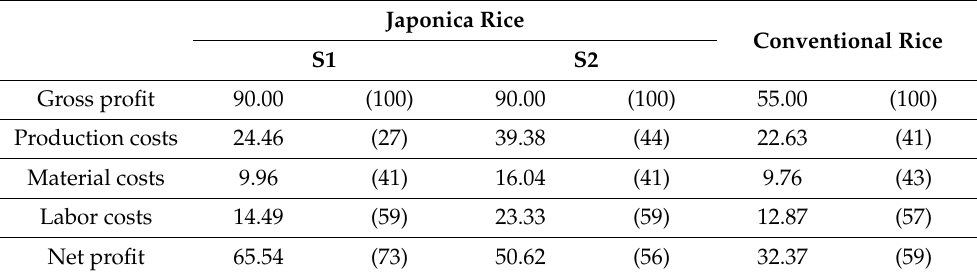
Table 6. Comparison of production costs between japonica rice and conventional rice under the same condition for bird scaring (unit: